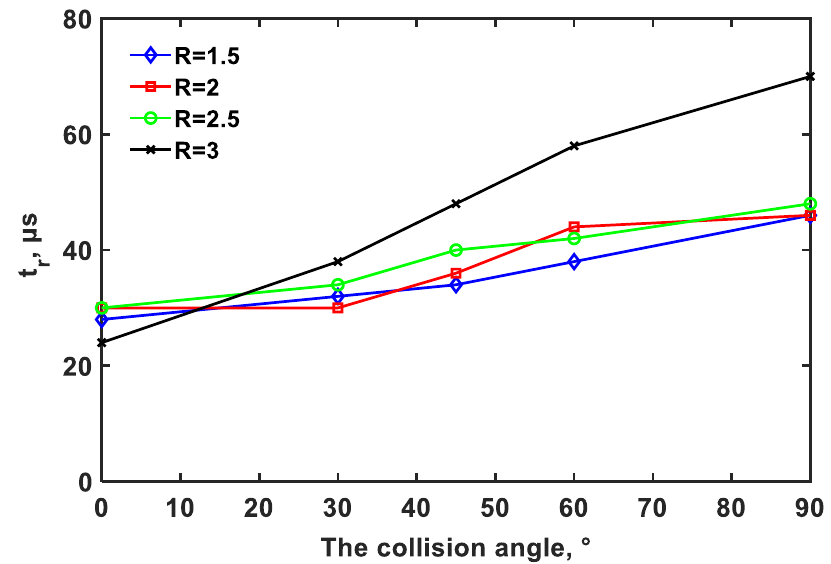
Figure 8. Effect of particle size ratio on collision mechanical properties.